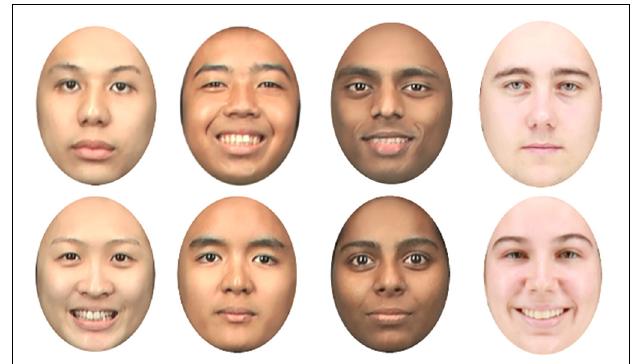
FIGURE 1 | Examples of cropped stimuli with happy and neutral expressions used in Experiment 1. Each column shows a male (top) and a female (bottom) face for each race group (left to right, Malaysian–Chinese, Malaysian–Malay, Malaysian–Indian, and Western–Caucasian). The individuals depicted in this figure gave written informed consent to the publication of their